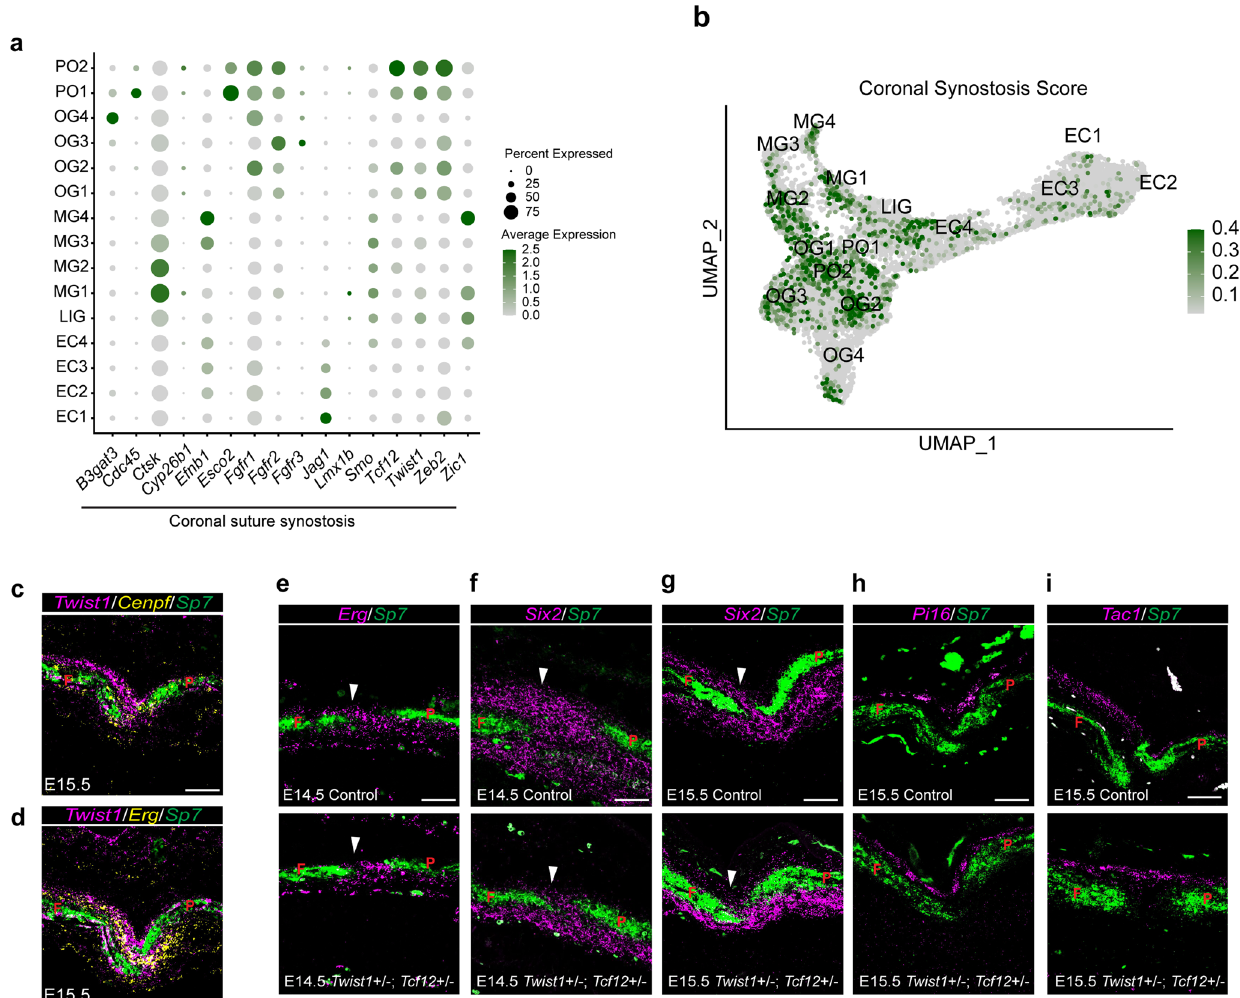
Fig. 7 Enrichment and requirements of coronal synostosis genes for osteogenic cells. a Dot plot of genes associated with coronal suture synostosis. The size and color intensity of the dots correspond respectively to the percentage of cells within each cluster expressing the indicated gene, and the average expression level. b Module score for coronal synostosis genes plotted on to the osteogenic/mesenchymal subset UMAP. c – i Combinatorial in situ analysis of coronal sutures for indicated markers at E14.5 or E15.5. Sp7 marks the frontal (F) and parietal (P) bones. c , d Twist1 expression overlaps with markers for PO1 ( Cenpf ) and OG1 ( Erg ) within coronal suture mesenchyme of wild-type E15.5 mice. e – i , expression of OG1 markers Erg and Six2 is lost in the suture mesenchyme (arrowheads) of Twist1 + / − ; Tcf12 + / − mice, yet EC1-3 marker Pi16 and LIG marker Tac1 are unaffected. In situs were performed in biological triplicate. Scale bars = 50 µ m; images in ( c – i ) are at the same magni